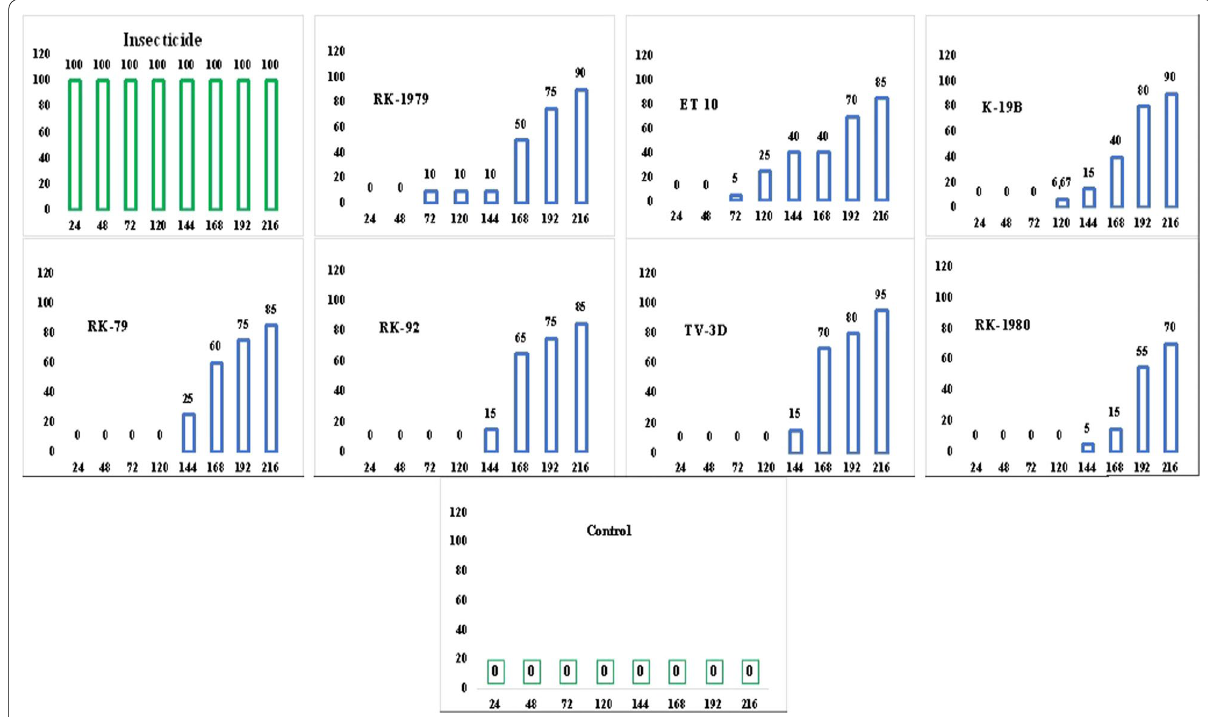
Fig. 2 Virulence effect of the applications on the last instar larvae of Cymbalophora